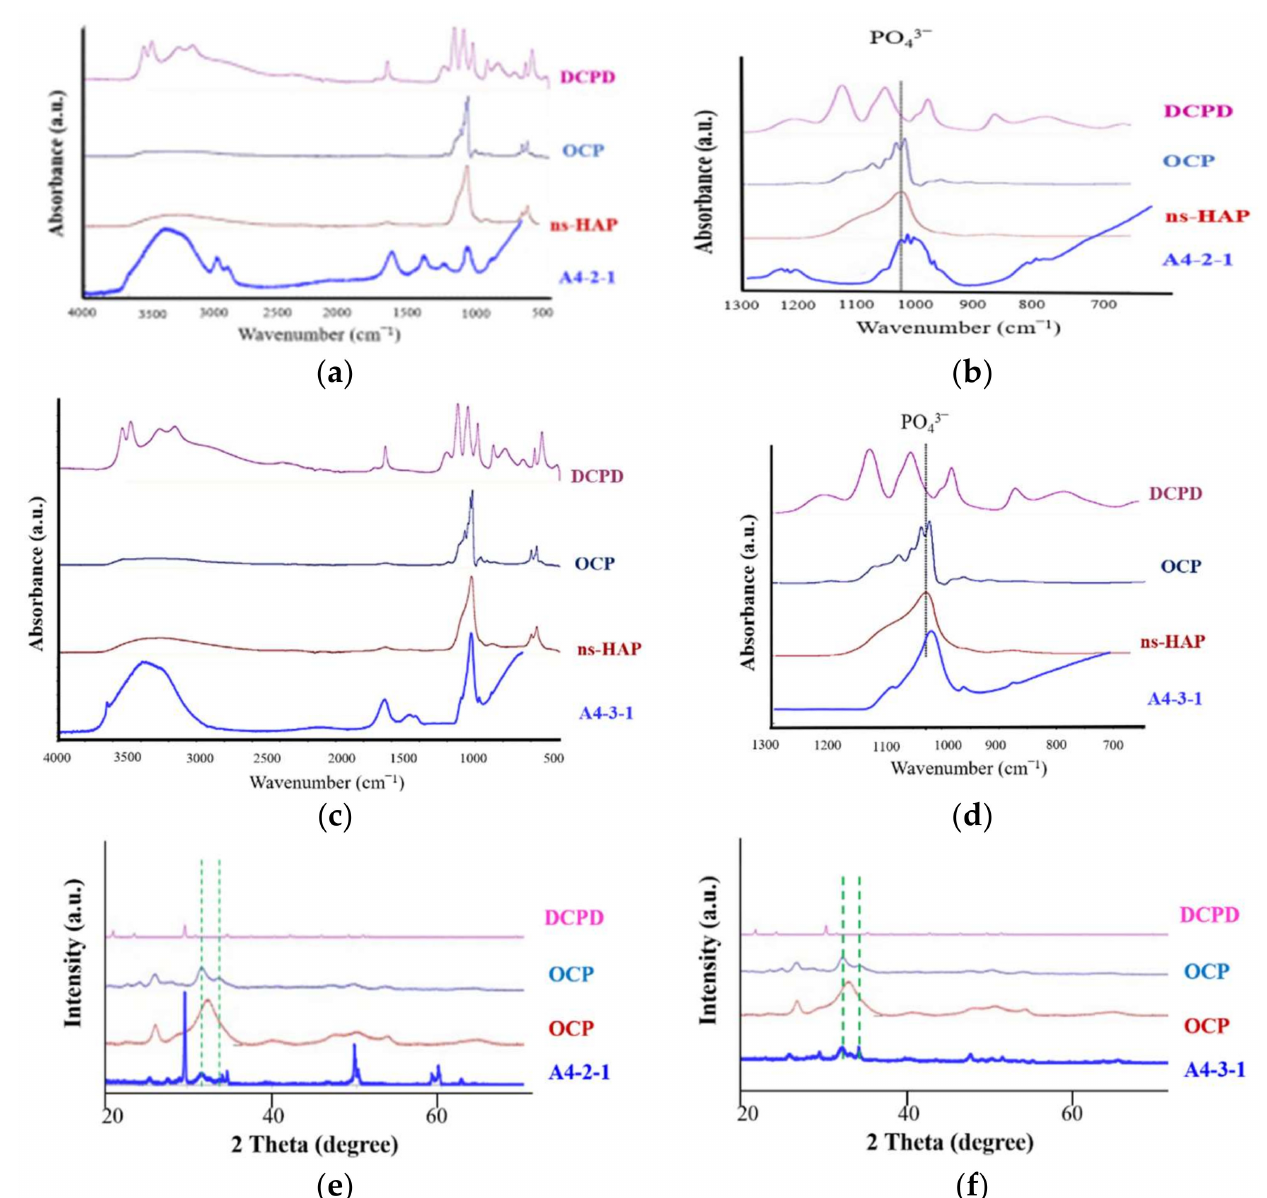
Figure 11. ( a , b ) A4-2-1 is compared to the crest of other calcium phosphate species via FTIR. ( b ) Detail of the 600–1300 degree interval in ( a ). ( c , d ) A4-3-1 compared with the crests of other calcium phosphate species via FTIR. ( d ) Detail of the 600–1300 degree interval in ( c ). ( e ) A4-2-1 is compared to the crest of other calcium phosphate species via XRD. ( f ) A4-3-1 is compared to the crest of other calcium phosphate species via